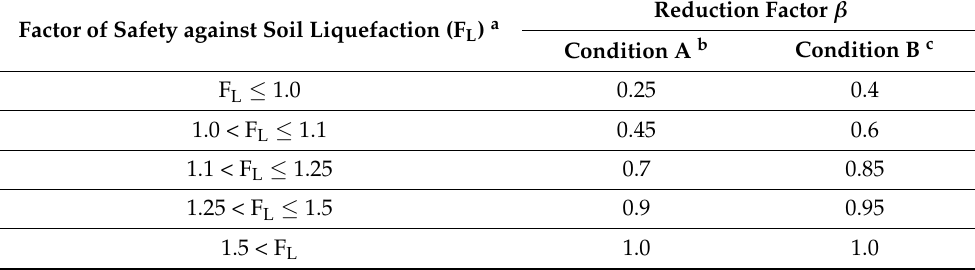
Table 3. Reduction factor β for soil liquefaction to the static factor of safety.